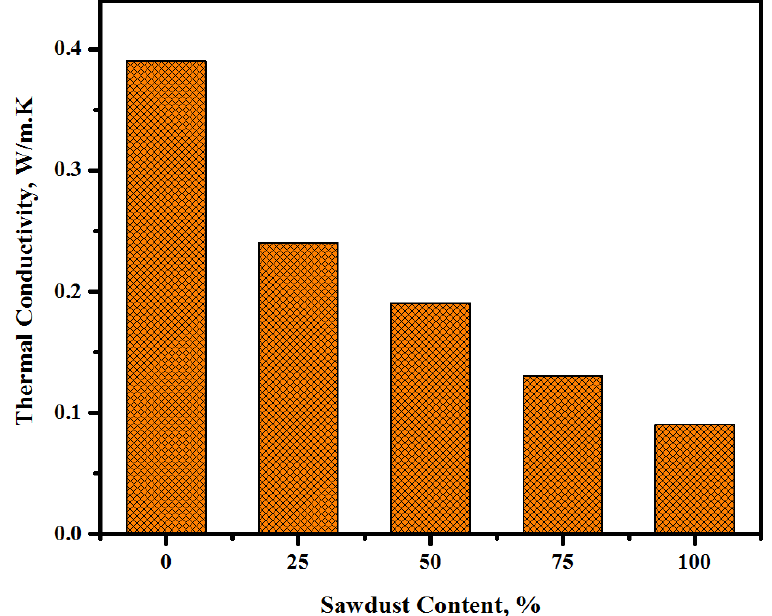
Figure 20. Thermal conductivity coefficients of the prepared concretes at various sawdust contents.